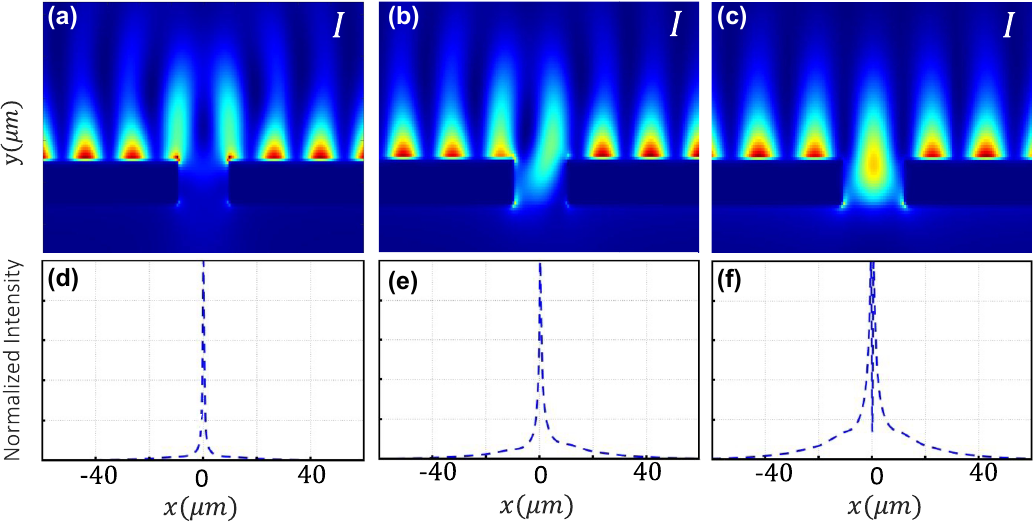
Figure 2: Panels (a–c) illustrate the intensity I of the near-field distribution of our designed nanoslit in the x – y plane. The blue dashed line in panels (d–f) show the normalized near-field interference pattern produced by the field transmitted by a 320-nm-wide slit. This corresponds to the scattered field described by mode ̂ e . The plots are obtained for 𝜑 = 0, 𝜑 = 𝜋 ∕ 2, and 𝜑 = 𝜋 ,